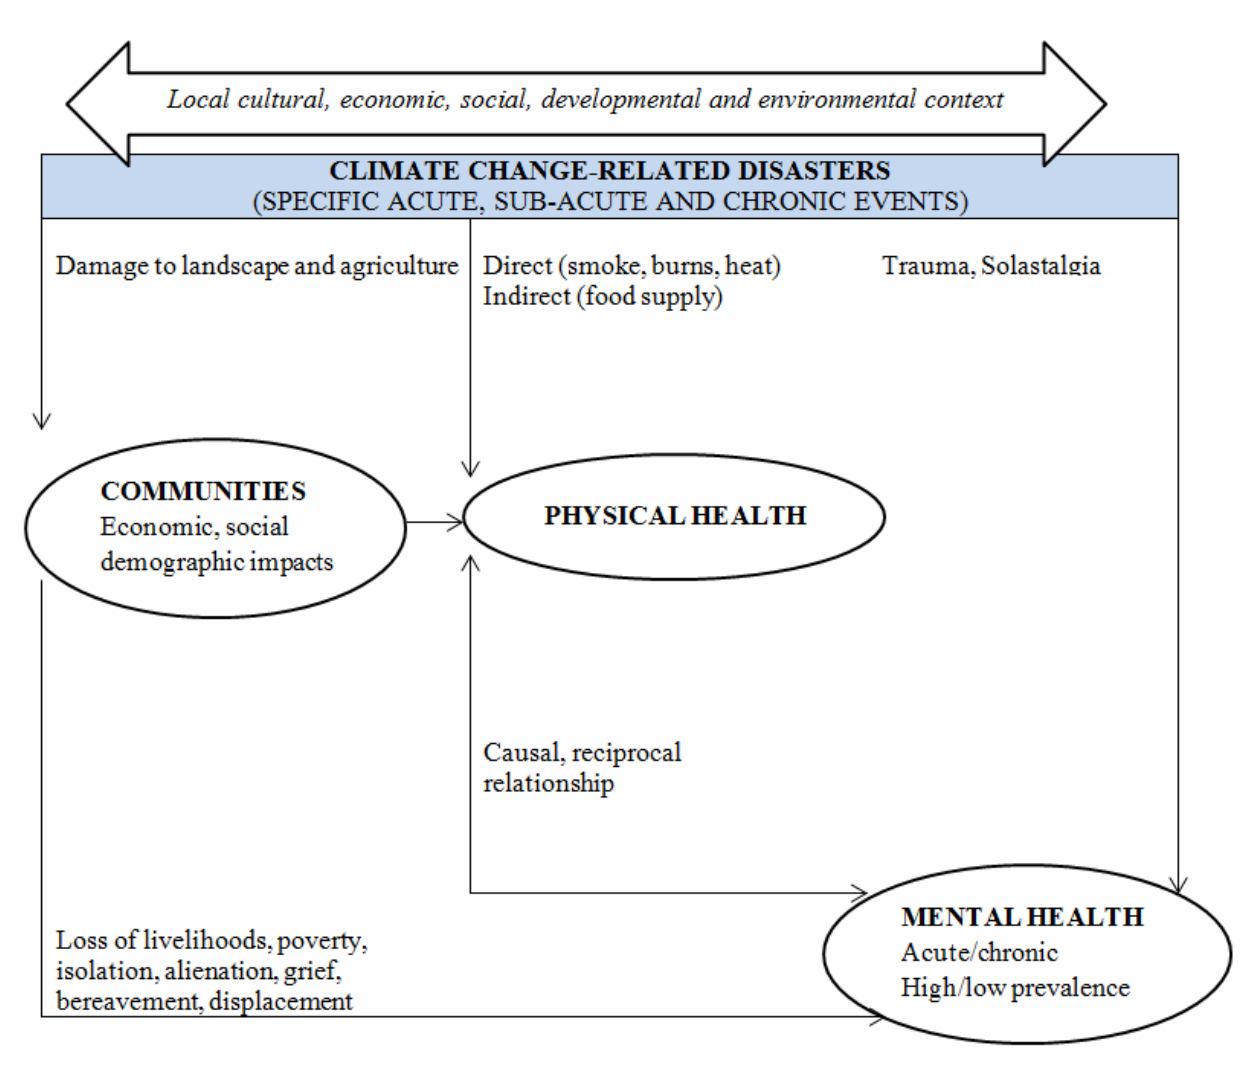
Figure 2. Pathways through which climate change-related disasters can affect mental health. Source: Reproduced from Berry et al.